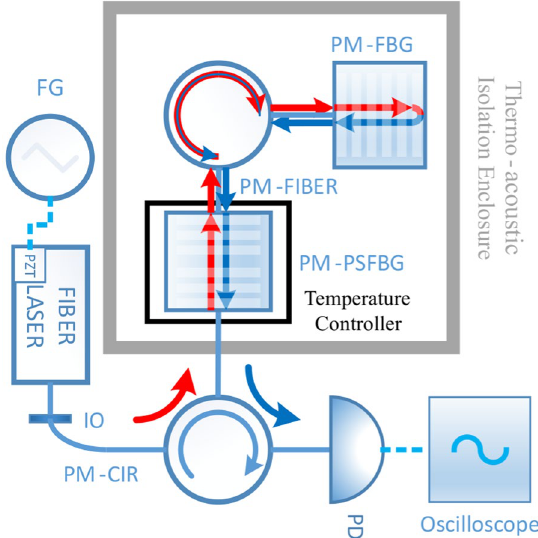
Figure 6. Sketch of the experimental setup. FG stands for function generator, IO for polarization maintaining isolation, PM-CIR for polarization maintaining circulator, PM-PSFBG for polarization maintaining phase- shifted fiber Bragg grating, PM-FIBER for polarization maintaining fiber, PM-FBG for polarization maintaining uniform fiber Bragg grating, and PD for photo detector. The PM-PSFBG is temperature-controlled by a temperature controller. The PSFBG-F-FBG resonator is thermo-acoustic isolated from environment by an isolation enclosure and vibration isolated by a flotation optical